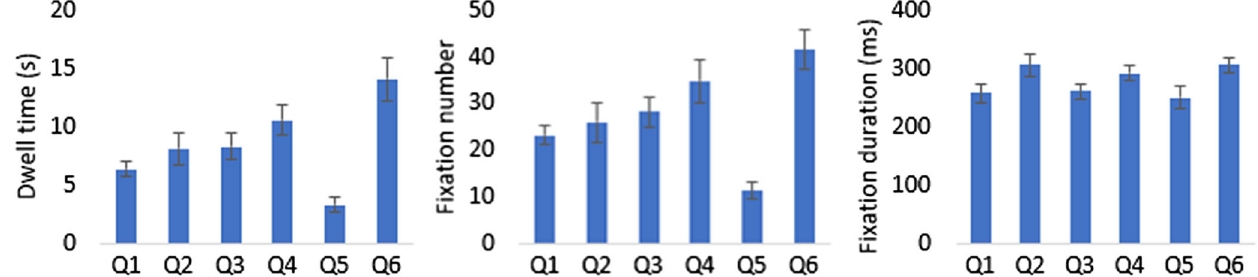
FIG. 4. Dwell time, number of fixations, and average fixation duration for the AOI diagram , for all questions (Q1 – Q6). The error bars represent 1 SEM.